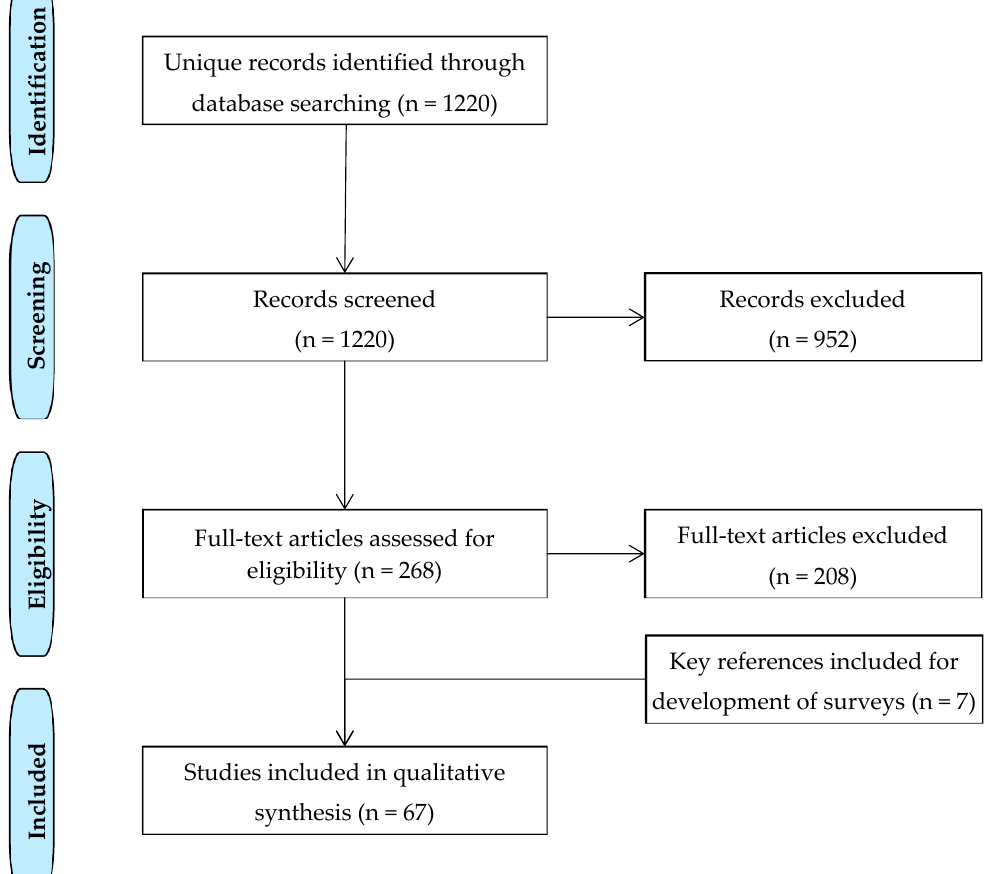
Figure 1. Systematic review methodology according Preferred Reporting Items for Systematic Reviews and Meta-Analyses (PRISMA) Statement, adapted from [14].